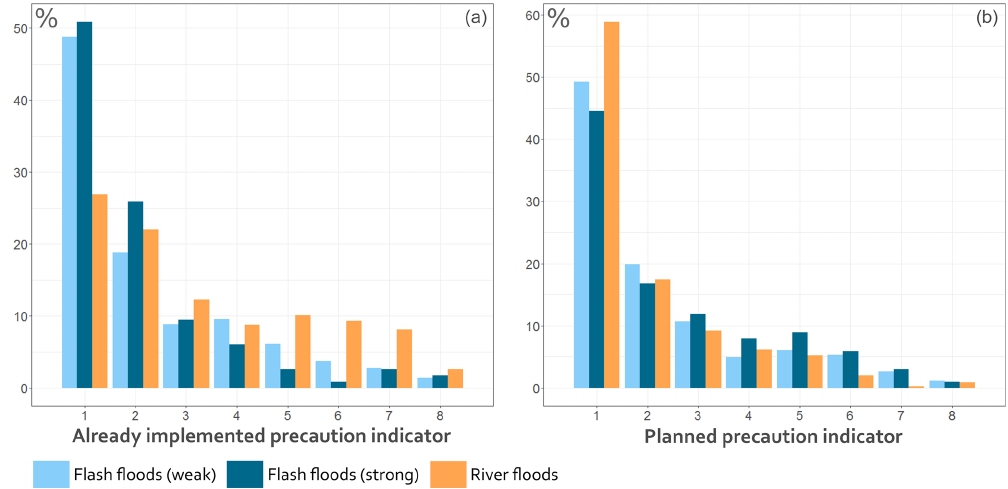
Figure 3. Relative distribution of the already implemented precaution indicator (a) and the planned precaution indicator (b) for weak flash floods ( n = 293), strong flash floods ( n = 116) and river floods ( n = 1366). The x axis represents the implementation of or the intention to implement effective precaution measures as described in Sect. 2.4. The higher the value, the more effective measures have been implemented or will be implemented in the near future.